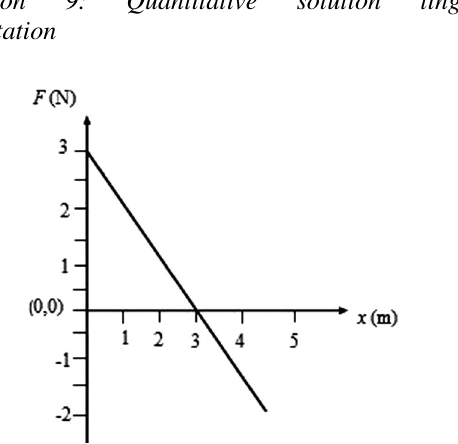
FIG. 25. Kinematics task with graphical format requesting qualitative solution.